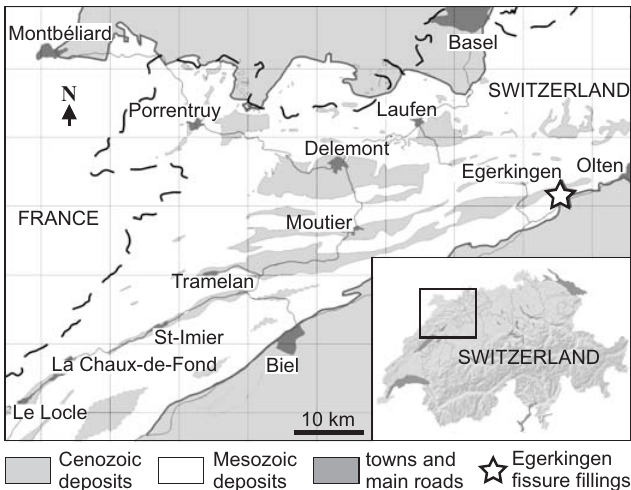
Fig. 1. Geographic position of the fossiliferous locality of Egerkingen. (Close-up on the Northwest Switzerland redrawn from Becker 2003: fig.